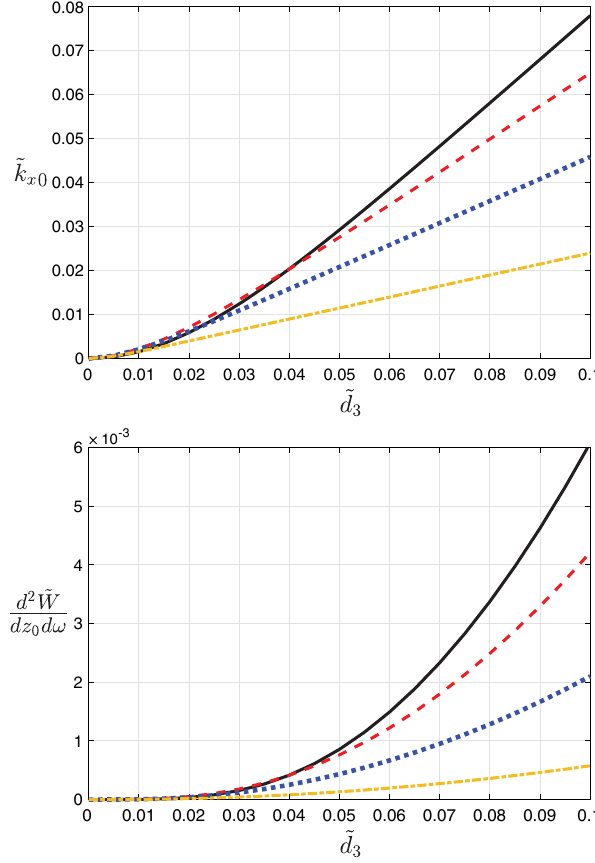
˜ k ˜ k FIG. 4. The wave vector projection FIG. 5. The wave vector projection x 0 and the spectral density x 0 and the spectral density ˜ W=d ω dz ˜ W=d ω dz of energy losses d 2 of energy losses d 2 0 depending on the depth of corru- 0 depending on the depth of corru- ˜ d ˜ d β → 1 , b ¼ 0 , d → 0 , β → 1 , b ¼ 0 , d ¼ 0 . 1 ; gations gations 3 for the following parameters: 0 1 3 for the following parameters: 0 d d → d ; d ¼ 0 . 05 (solid black curves); d ¼ 0 . 1 (dashed red → 0 , d → d (system of diaphragms, solid black curves); 2 1 2 d ¼ 0 . 025 , d ¼ 0 . 075 , (dashed red curves); d ¼ d ¼ 0 . 05 curves); d ¼ 0 . 15 (dotted blue curves). All parameters of corru- 1 2 1 2 (dotted blue curves); d 1 ¼ 0 . 075 , d 2 ¼ 0 . 025 (dashed-dotted gated structure are in units k − 1 0 . yellow curves). All parameters of corrugated structure are in units k − 1 0